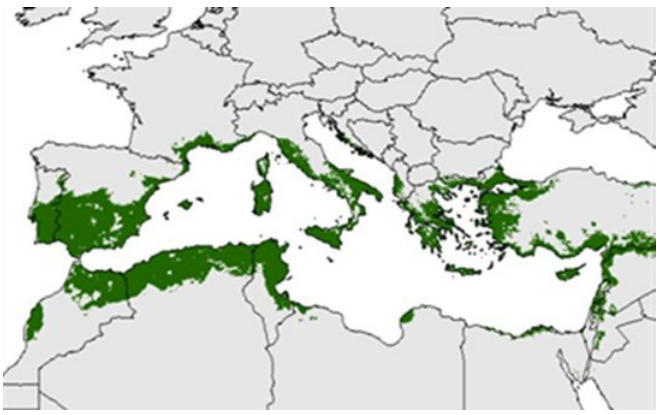
Figure 1: Ecological niche of the potential olive tree